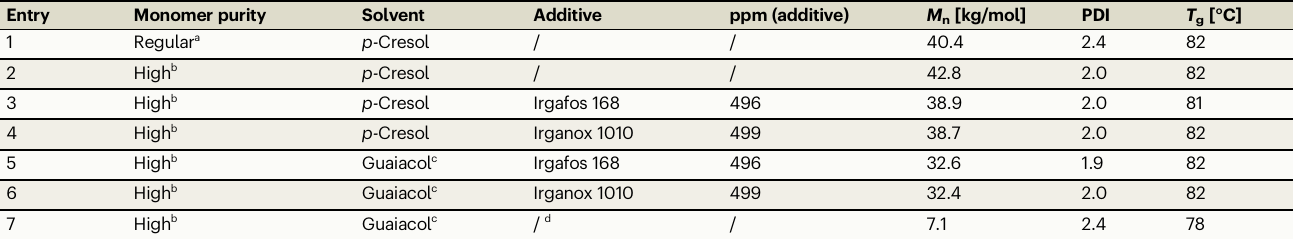
Table 4 | In fl uence of monomer purity, thermal stabilizers, and aryl alcohol choice on poly(isosorbide succinate) molecular